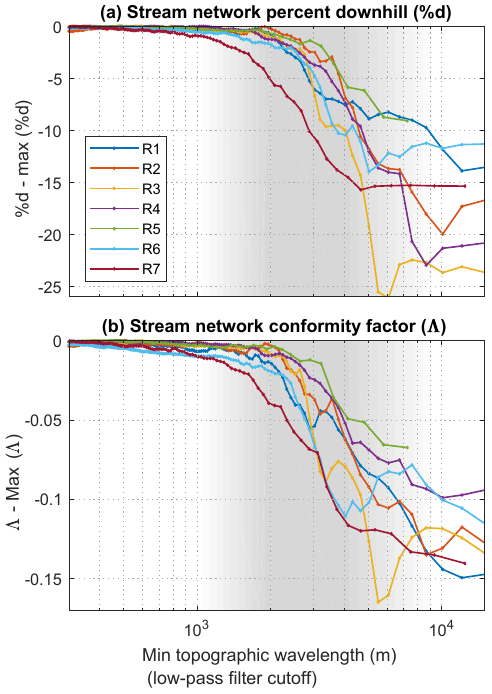
Figure 10. (a) Percent downhill % d . (b) Conformity factor (cid:51) . Val- ues for both stream metric topographic conformity metrics are cal- culated in our seven study regions (Fig. 1a, Table 1). All values are normalized to the maximum values in each network due to the variability in plateau values of % d and (cid:51) among networks. For all supraglacial stream networks the cutoff filter wavelengths over which % d and (cid:51) decrease most significantly are between ∼ 1 and 10km (shaded regions), similar to the bed topography wavelengths predicted to transfer most strongly (Fig.